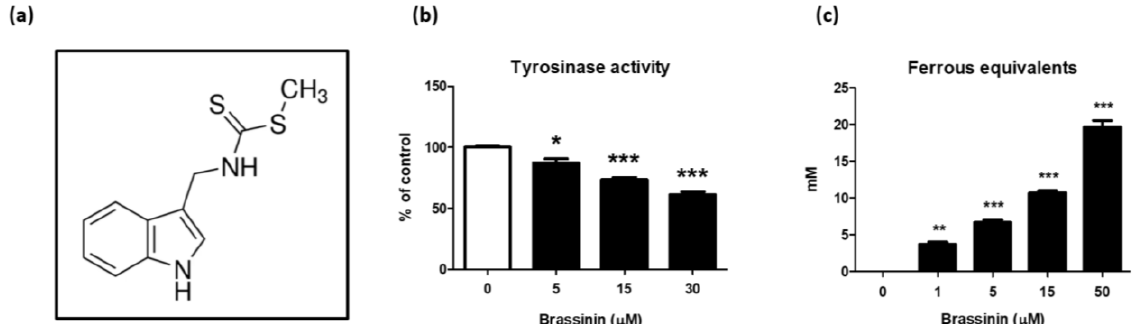
Figure 1. Inhibitory effects of brassinin on mushroom tyrosinase activity and oxidative stress in test tubes. ( a ) The chemical structure of brassinin. ( b ) The tyrosinase inhibitory activity of brassinin was measured in the cell-free system using mushroom tyrosinase as an enzyme and L-tyrosine as a substrate ( n = 3/group). ( c ) The antioxidant activity of brassinin was determined by FRAP assay in a cell-free system ( n = 3/group). Results are presented as a mean ± SEM. * p < 0.05, ** p < 0.01, *** p < 0.001 compared with the non-treated control group.